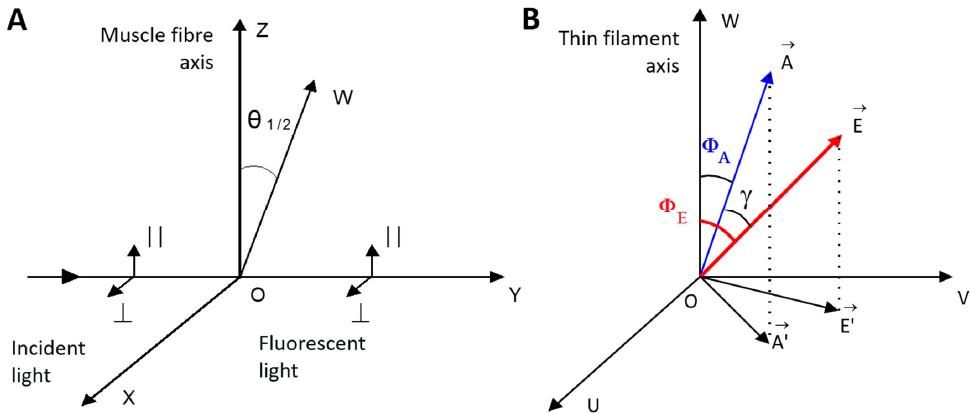
Figure 10. Diagrams explaining the calculation of the polarized fluorescence parameters. ( A ): The laboratory frame is taken as OXZY, where OY is the direction of propagation of incident and emitted light. OZ is the axis of the muscle fiber. θ 1/2 is the angle between the actin filament axis (OW) and the fiber axis (OZ) at parallel ( (cid:107) ) or perpendicular ( ⊥ ) direction of excitation light. ( B ): The molecular frame for the thin filament is taken as OUVW, where OW is the filament axis. The direction of the → → absorption dipole A and emission dipole E for a fluorescent probe are defined by the angles Φ A and → → → → Φ γ and δ are the angles between A and E, and A (cid:48) , and E (cid:48) dipoles, E , respectively.